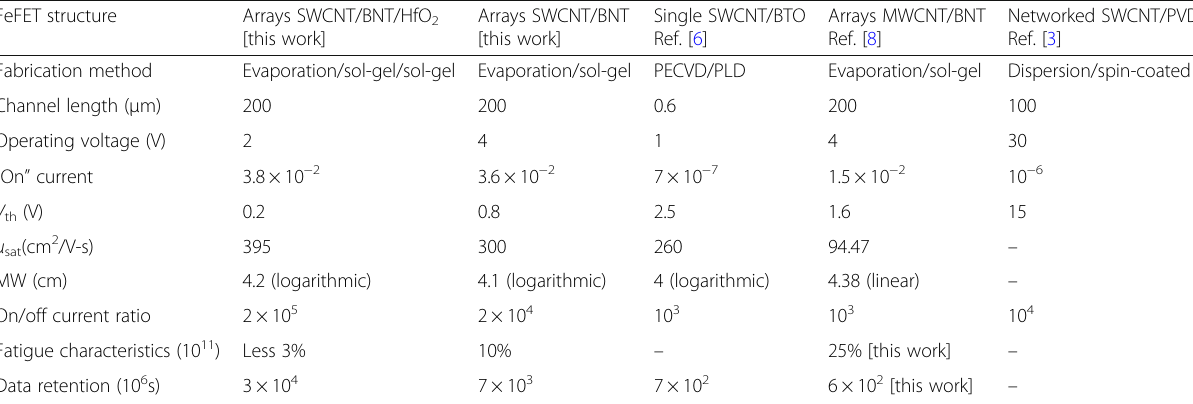
Table 1 Comparison of ferroelectric-based FETs with different CNT FeFET structure